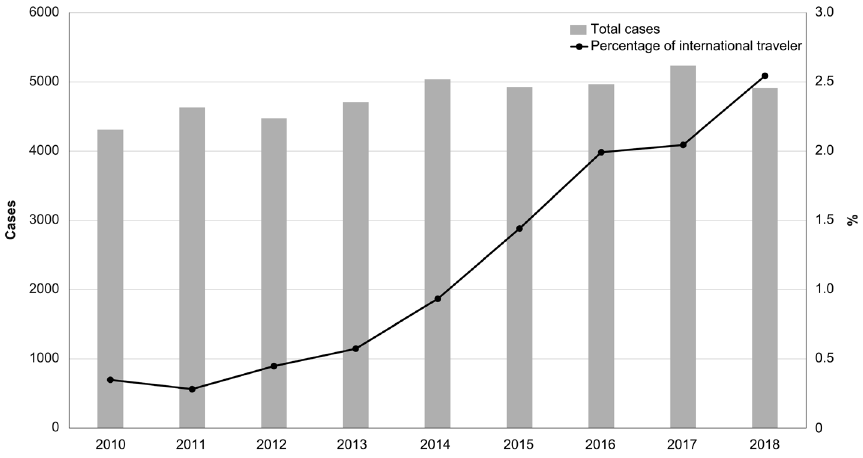
Figure 1. Annual Ambulance Dispatch Levels and Usage by International Travelers.